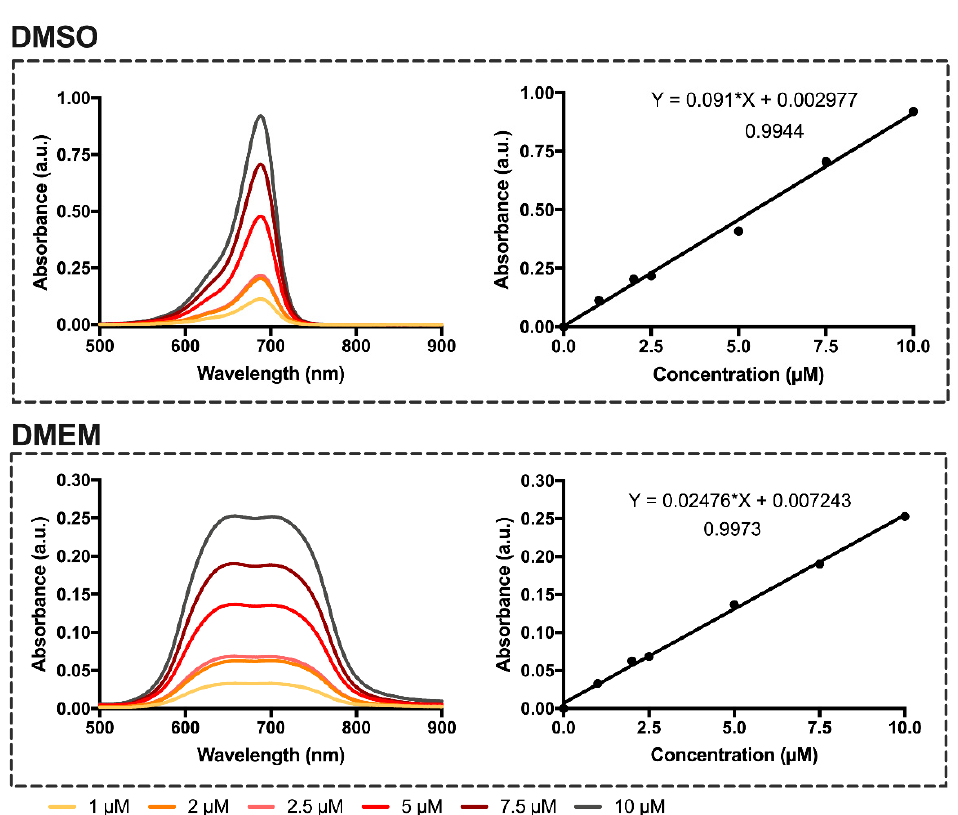
Figure 3. Absorption spectra of dicyanomethylene squaraine dye 5 in dimethyl sulfoxide and serum-free Dulbecco’s Modified Eagle Medium (DMEM) at concentration range 1–10 µ M. Linear regression of the dyes’ monomer absorbance as a function of concentration in dimethyl sulfoxide and cell culture medium, equation of the lines and correlation coefficient. Absorbance is present as arbitrary units (a.u.).